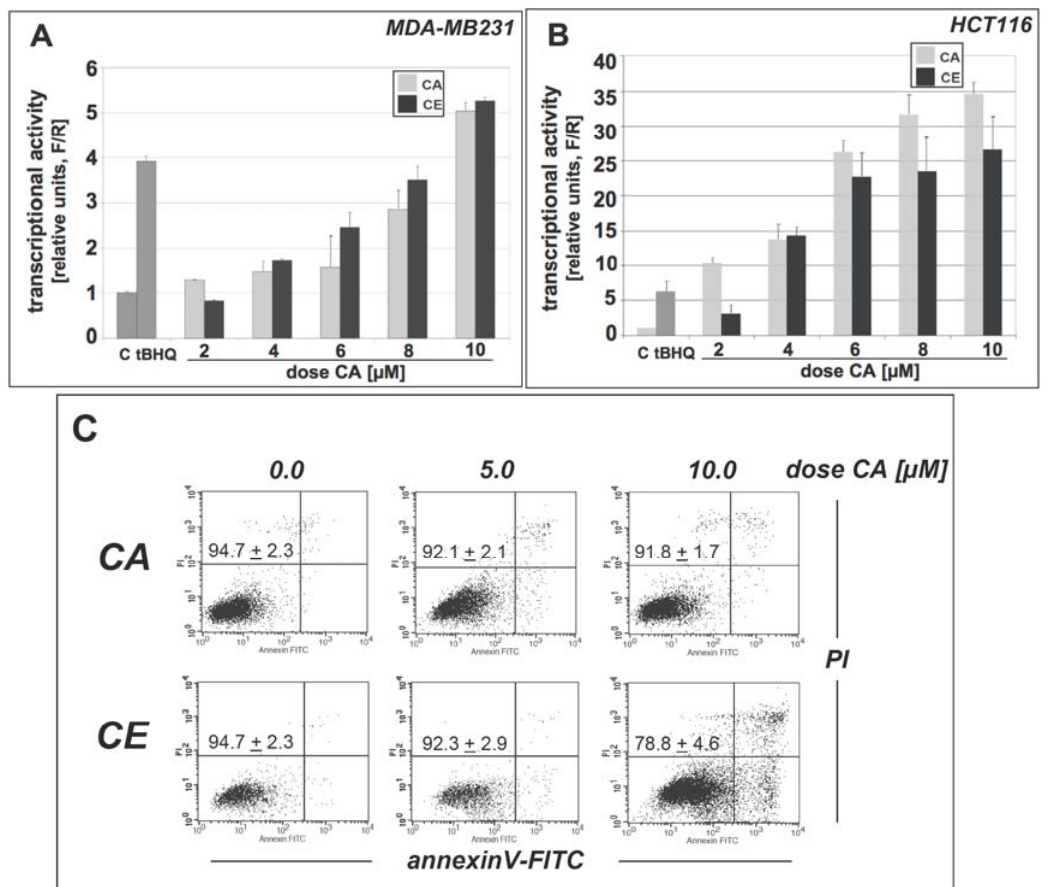
Figure 2. Dose response of Nrf2 transcriptional activation by cinnamic aldehyde and an ethanolic cinnamon extract in MDA-MB231 breast carcinoma and HCT116 colon carcinoma cells. (a-b) MDA-MB-231 cells (panel a) or HCT116 (panel b) were cotransfected with plasmids containing a GST-ARE-firefly luciferase reporter gene and expression plasmids for the Nrf2 and Keap1 proteins. A plasmid encoding renilla luciferase, driven by the herpes simplex virus thymidine kinase promoter, was included in all transfections to normalize transfection efficiency. Twenty-four hours post-transfection, cells were dosed with the indicated concentrations of each compound (tBHQ: 50 µM) for 16h. Firefly and renilla luciferase activity was measured and is expressed as relative activity (F/R) compared to untreated control ( p < 0.05 for CA doses ≥ 4 µM; differences between CA and CE not significant). (c) HCT 116 cell viability in response to CA and CE exposure (24 h) was assessed by flow cytometry as detailed in Materials and Methods. Numbers indicate viable cells as percentage of total gated population (mean ± SEM, n =